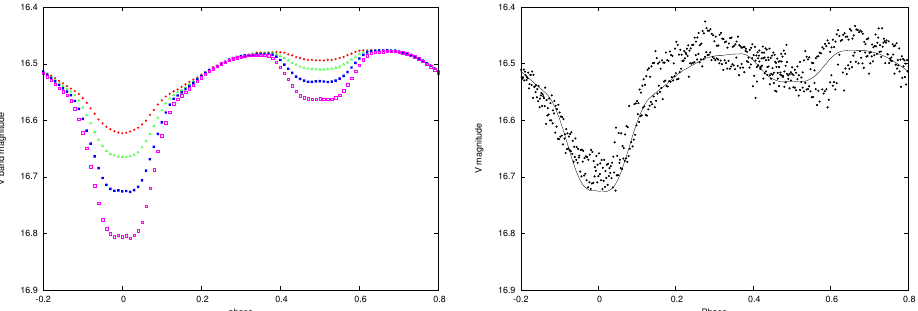
Figure 4. ( Left ) panel: Synthesized eclipsing-tidal-reflection waveforms (Resolution II), phased with WW’s adopted orbit period of 0. d 1026. Light dilution due to fractional third light [ (cid:96) 3 / ( (cid:96) 1 + (cid:96) 2 + (cid:96) + (cid:96) ) ] is similar to that for Resolution I. The orbital inclinations are 65 ◦ (red dots), 70 ◦ (green V 3 disk triangles), 75 ◦ (filled blue squares), and 80 ◦ (empty magenta squares). Other parameter values are the same as for Resolution I. ( Right ) panel: The 75 ◦ inclination case is plotted among the observations as a continuous